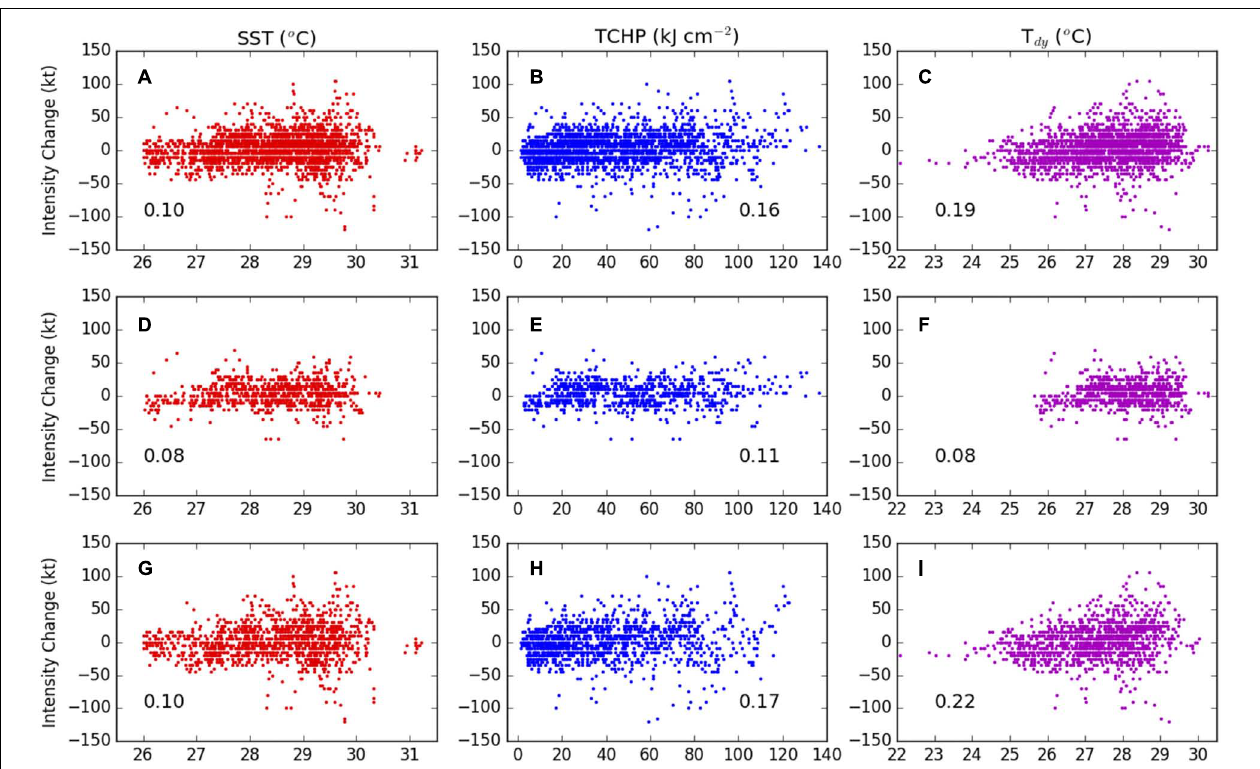
FIGURE 5 | Scatter between 36-h intensity changes of Atlantic TCs and SST (red), TCHP (blue), and Tdy (magenta) for the 10-year period 2005–2014. (A–C) All storm locations, (D–F) cases where the magnitude of the hurricane-induced SST cooling is below 0.5 ◦ C, and (G–I) cases where the cold wake magnitude is greater than 0.5 ◦ C. Correlation coefficients are also indicated in each panel. Reproduced from Balaguru et al.